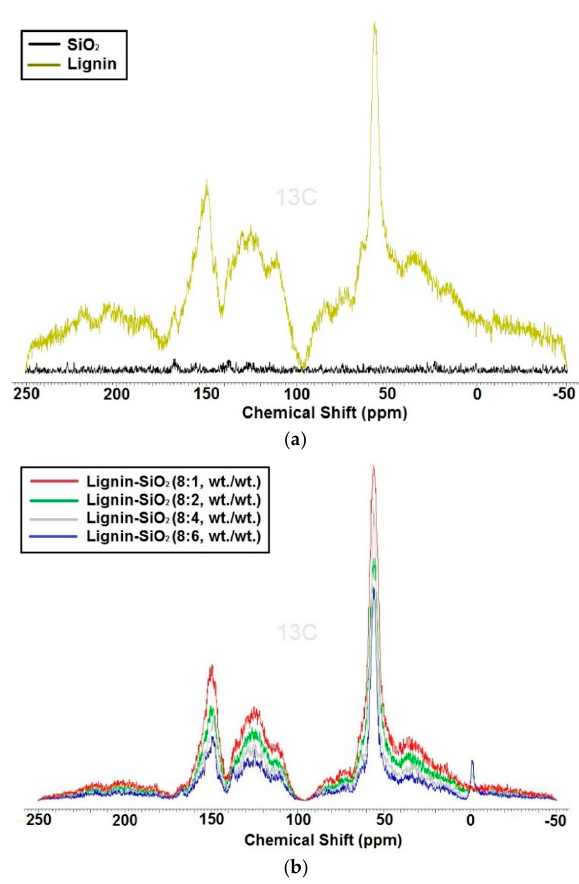
Figure 2. 13 C CP MAS NMR spectra of: lignin and silica ( a ); and lignin–silica hybrid fillers ( b ).